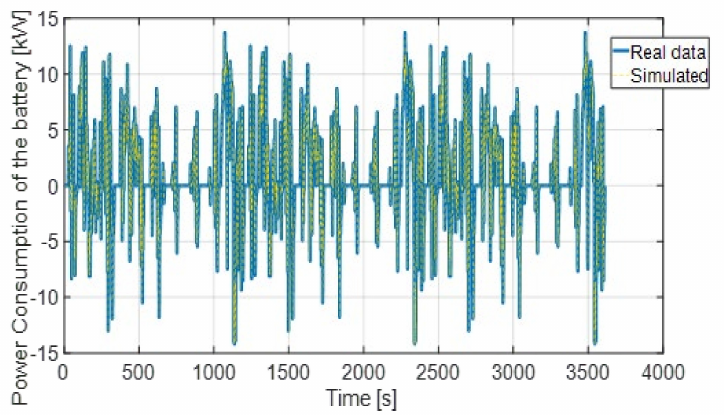
Figure 28. Comparison of a short estimation test for the power